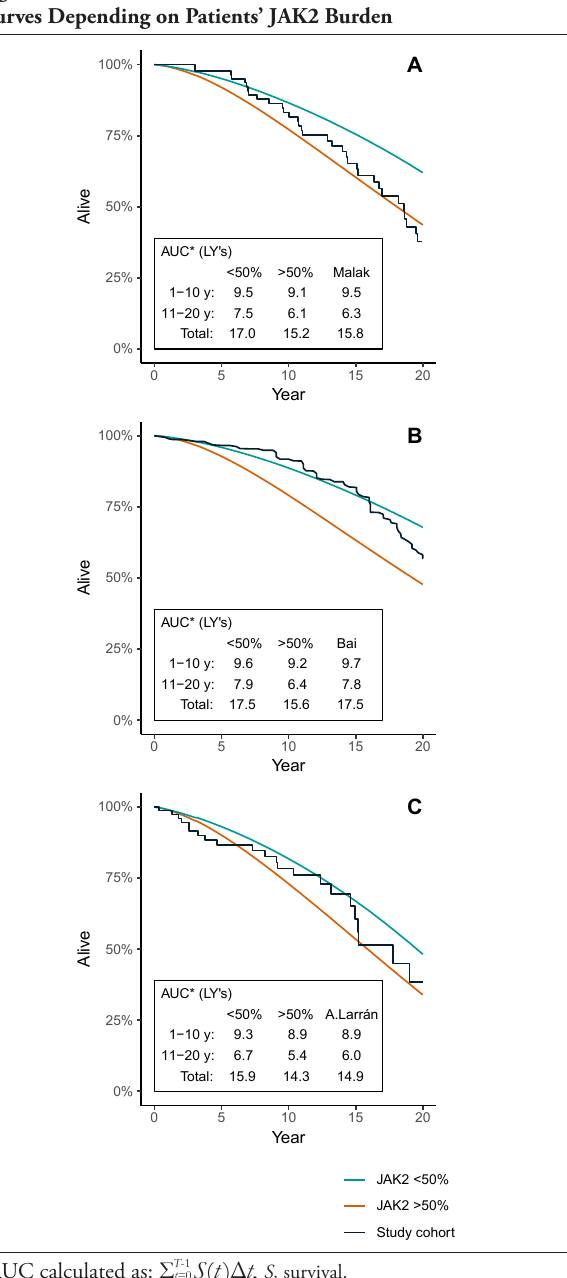
Figure 4. KM Curves of Real-Life Studies and Modeled Survival Curves Depending on Patients’ JAK2